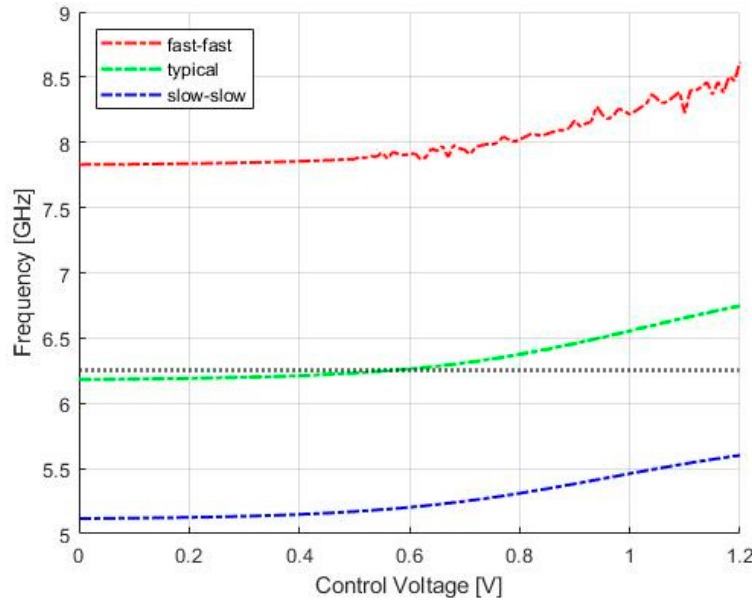
Figure 8. RO-VCO post-layout simulation of the free-running frequency versus control voltage in fast-fast ( red line ), typical ( green line ), and slow-slow ( blue line ) technology corner cases. The horizontal marker indicates the target frequency.